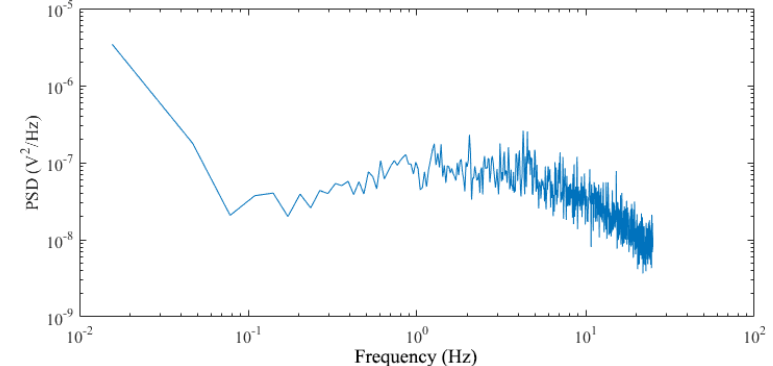
Figure 11. The measured frequency response of (cid:2157) (cid:2204),(cid:2160)(cid:2157) .